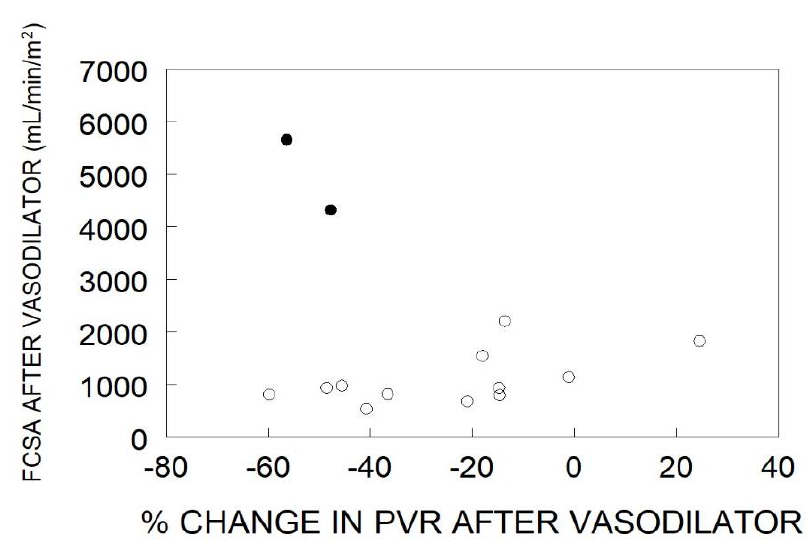
Figure 3. Functional capillary surface area normalized to body surface area (FCSA, mL/min/m 2 ) in human lungs post acute vasodilator therapy, as compared to percent change in pulmonary vascular resistance (PVR) after administration of a vasodilator. The open circles represent “resistance” responders and the filled circles represent “pressure” responders. Data have been adapted from reference [32].